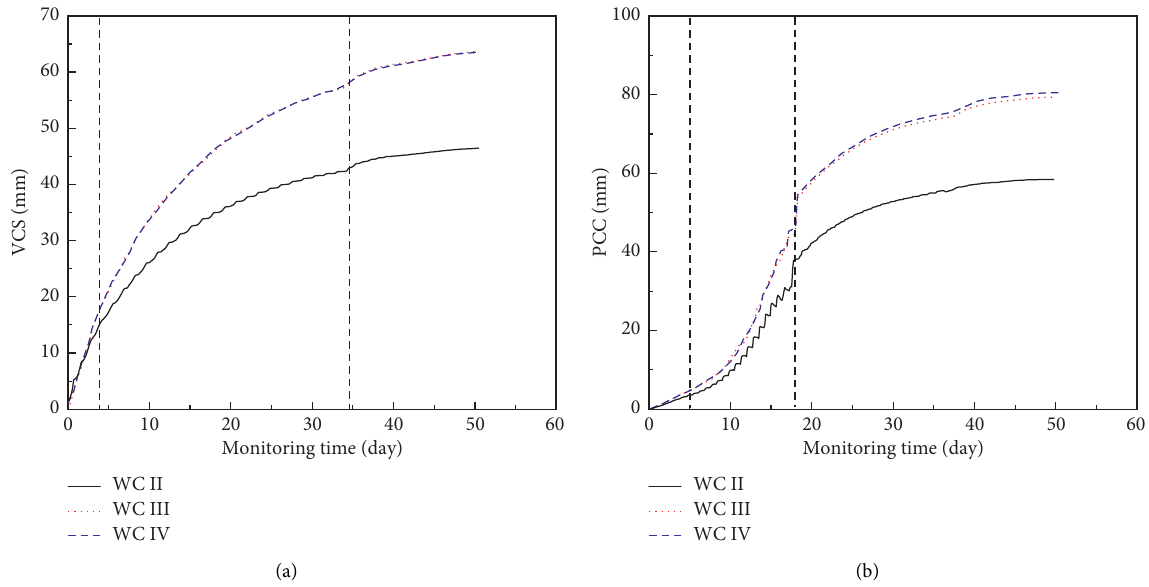
Figure 13: The effect of changing the rigidity of the steel arch on tunnel deformation. (a) The VCS of WC I, WC II, and WC IV. (b) The PCC of WC I, WC II, and WC IV.